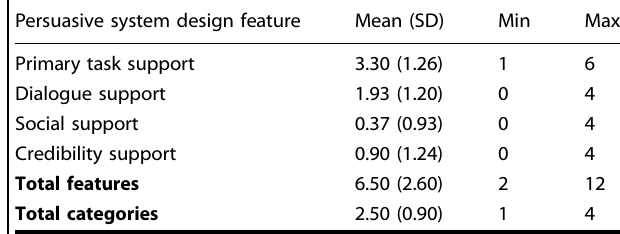
Table 3. Average persuasive system design features and